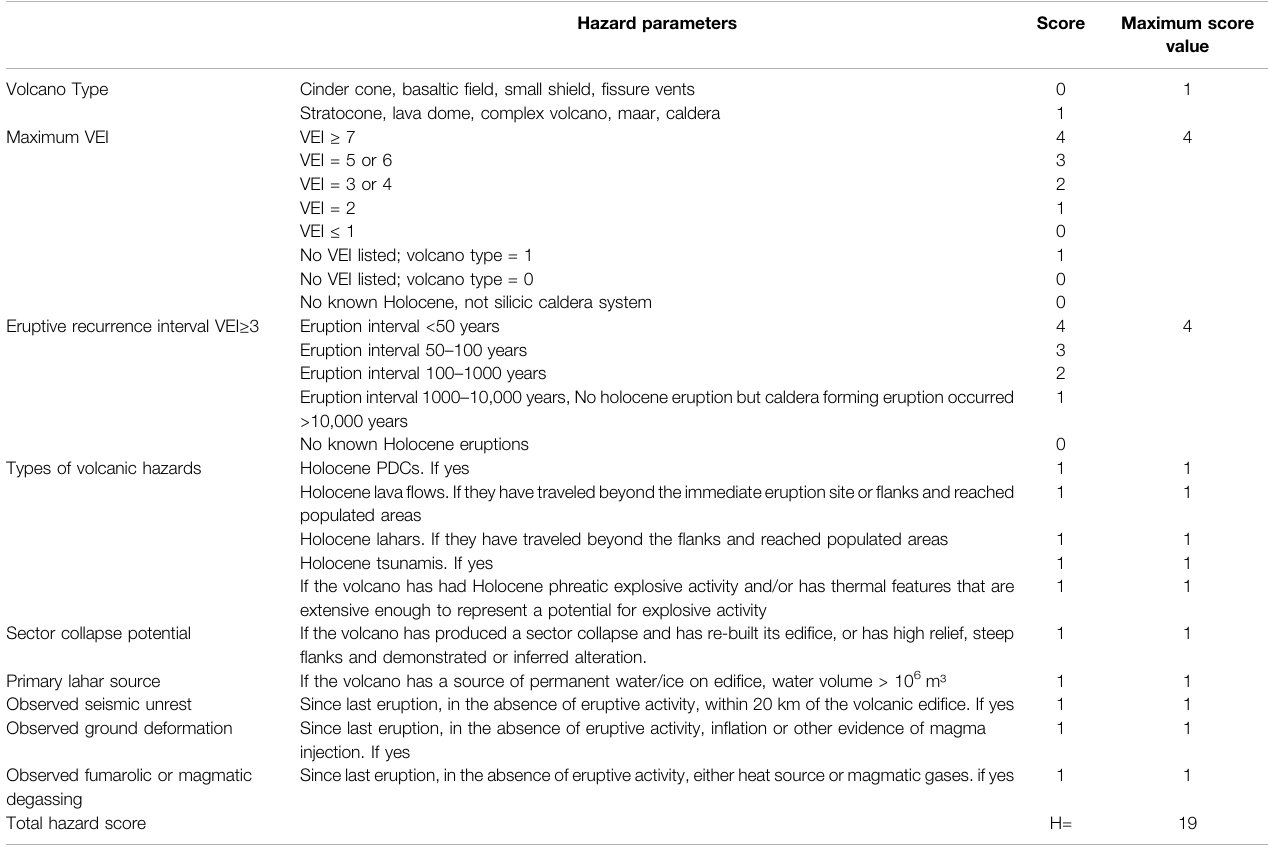
TABLE 1 | Hazard parameters evaluated in the new ranking strategy (adapted from Ewert et al.